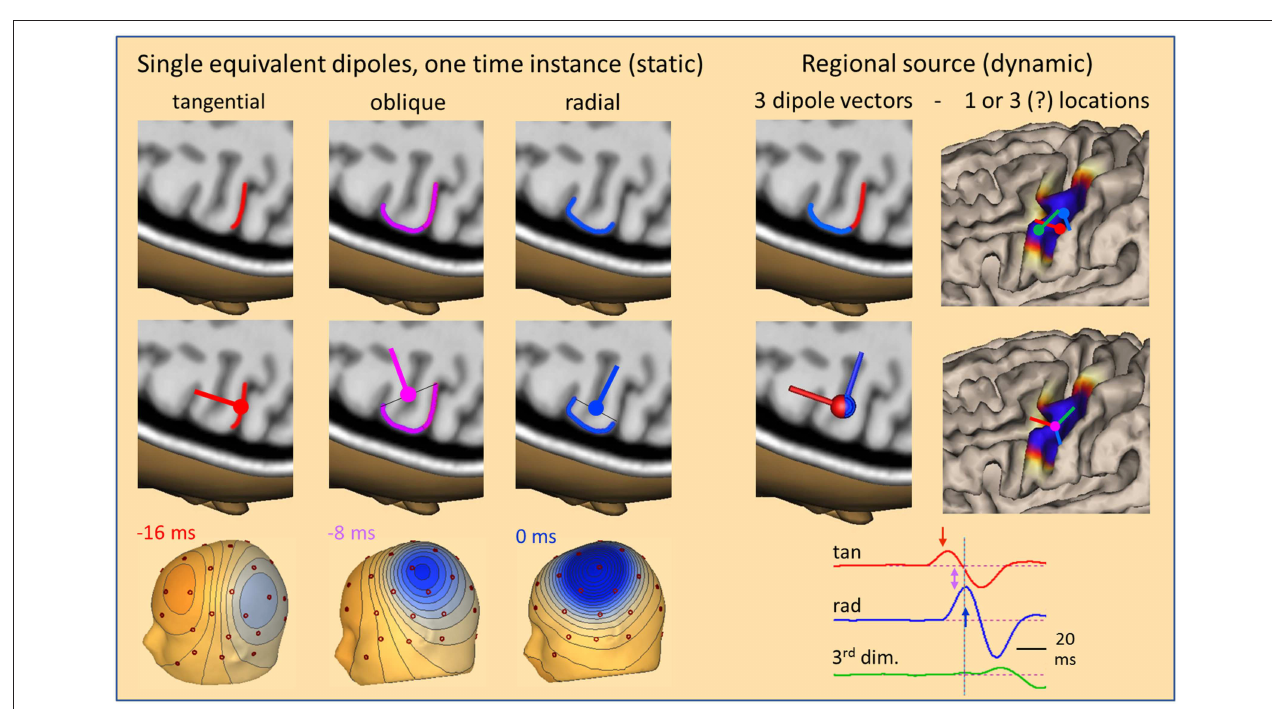
FIGURE 4 | The local source space. Using snapshots at one time instance as in Figure 1 , we can define the local source space by a single equivalent dipole ( left ) moving from the sulcus ( − 16ms, tangential) into the white matter ( − 8ms, oblique) and closer to the surface (0ms, radial). The changes in location are very small, but orientation changes completely, rotating from tangential through oblique to radial within 16ms. The cross-sections of the active patch at each time are illustrated by lines. The equivalent dipole is located at their midpoint. An alternative local source space is defined by a regional source ( right ) having 3 orthogonal dipoles at a common center location to describe the 3-dimensional volume currents with high precision and rotational invariance. When rotated appropriately, the radial dipole depicts the superficial and the 1st tangential dipole the sulcal currents. Their source waveforms (right bottom) show the contribution of the local source space to the measured data. For more details see